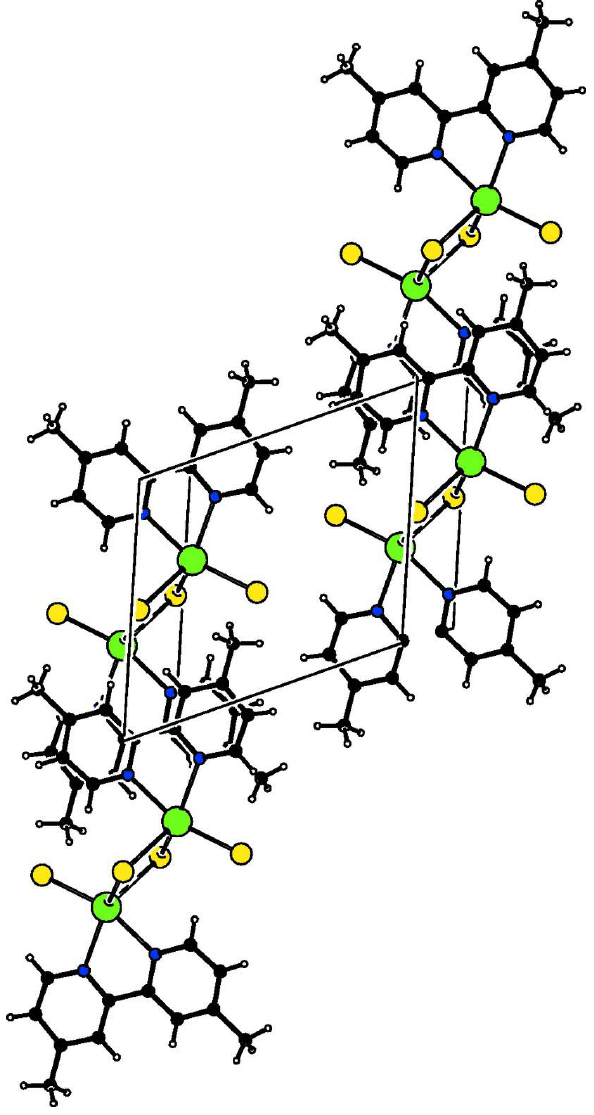
Figure 2 A partial packing diagram of the title